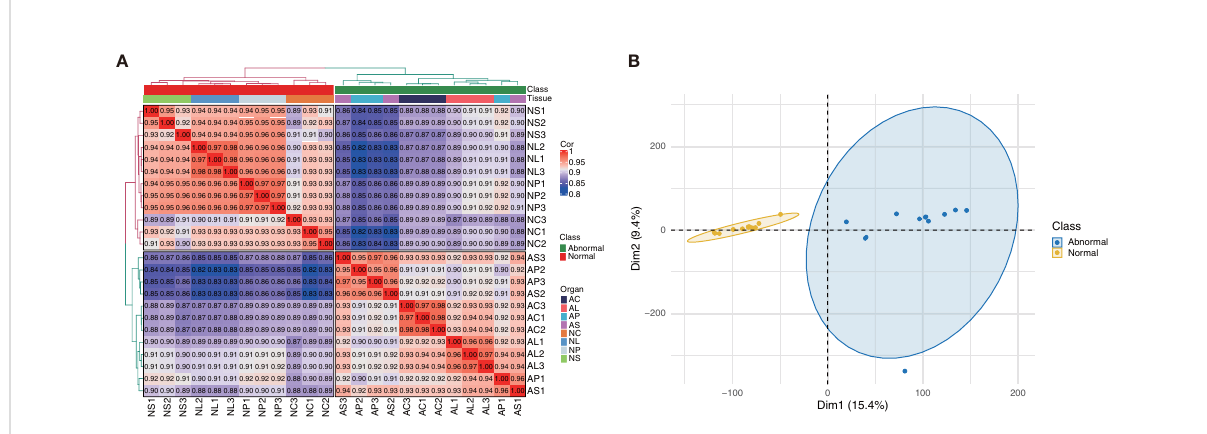
FIGURE 2 (A) Heatmap showing correlations between samples (Spearman method). (B) PCA analysis of C. nanulum Y. S. Wu & S. C. Chen fl ower produced in vitro